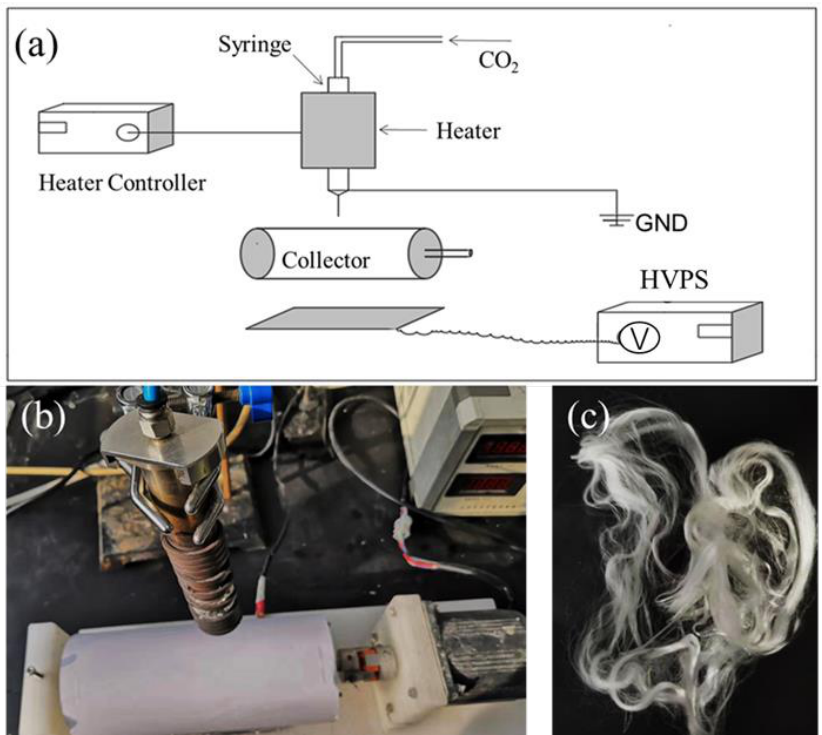
Figure 1. ( a ) Home-made melt e-spinning device; ( b ) heating device; ( c ) melt e-spun polypropylene (PP) fibers.